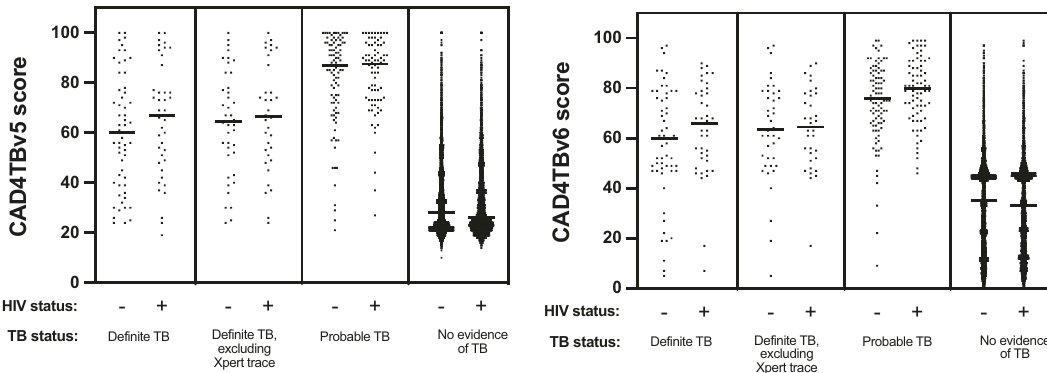
Fig. 3 CAD4TB scores differ by TB but not HIV status. CAD4TB v5 ( a ) and v6 ( b ) distributions across TB diagnostic groups: de fi nite TB (microbiologically proven n = 99), de fi nite TB, trace excluded (a more stringent group that excludes those whose only microbiological evidence of TB is an Xpert “ trace ” results, n = 75), probable TB (radiologically diagnosed, n = 172), and no evidence of TB ( n = 9643). Scores in each group were strati fi ed by HIV status (de fi nite TB HIV-positive: n = 41, HIV-negative: n = 57; de fi nite TB, trace excluded HIV-positive: n = 34, HIV-negative: n = 40; probable TB HIV-positive: n = 76, HIV-negative: n = 96; no TB HIV-positive: n = 2837, HIV-negative: 6755). Horizontal lines mark the median. P -values from comparisons between HIV-positive vs. HIV-negative in each diagnostic group were for de fi nite TB: 0.26 (v5), 0.26 (v6), de fi nite TB, trace excluded: 0.70 (v5), 0.95 (v6), probable TB: 0.88 (v5), 0.06 (v6) no TB 2.9x10-5 (v5), 0.70